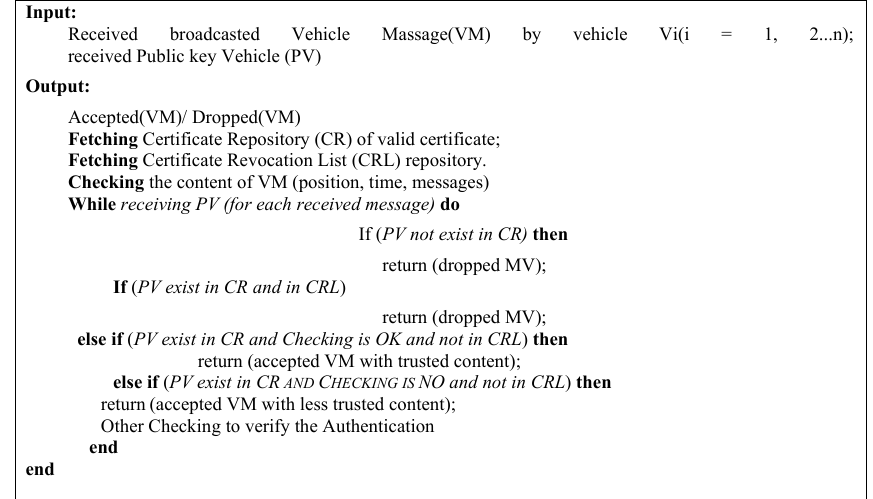
Algorithm 1. Validation Process Algorithm.